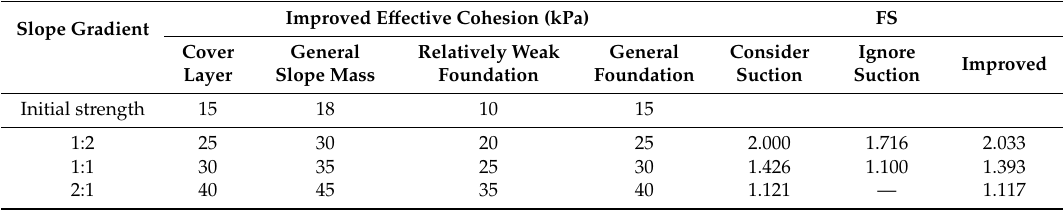
Table 3. The comparison of the two cases considering or ignoring suction. Improved E ff ective Cohesion (kPa) FS Slope Gradient Cover General Relatively Weak General Consider Ignore Layer Slope Mass Foundation Foundation Suction Suction